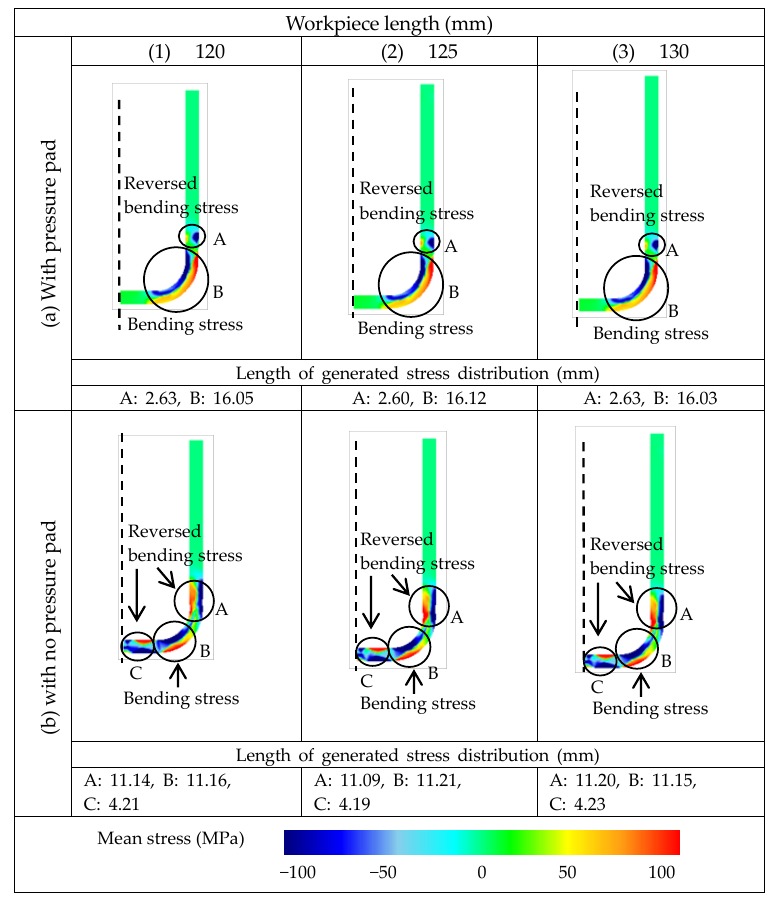
Figure 12. Comparison of the stress distribution analyzed in the workpiece, before unloading, with respect to various workpiece lengths (θ: 90°, R p : 7 mm, W : 30 mm, t : 3 mm, R ud : 5 mm).